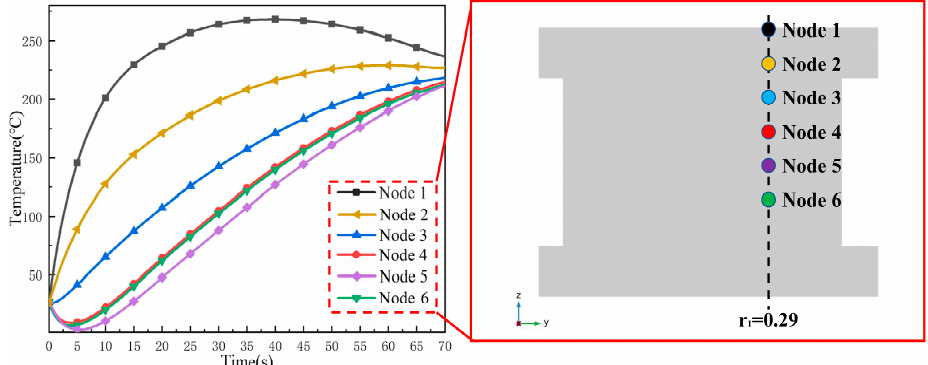
Figure 13. Temperature profile of the nodes along with the axial distribution of the gap structure as a function of time.